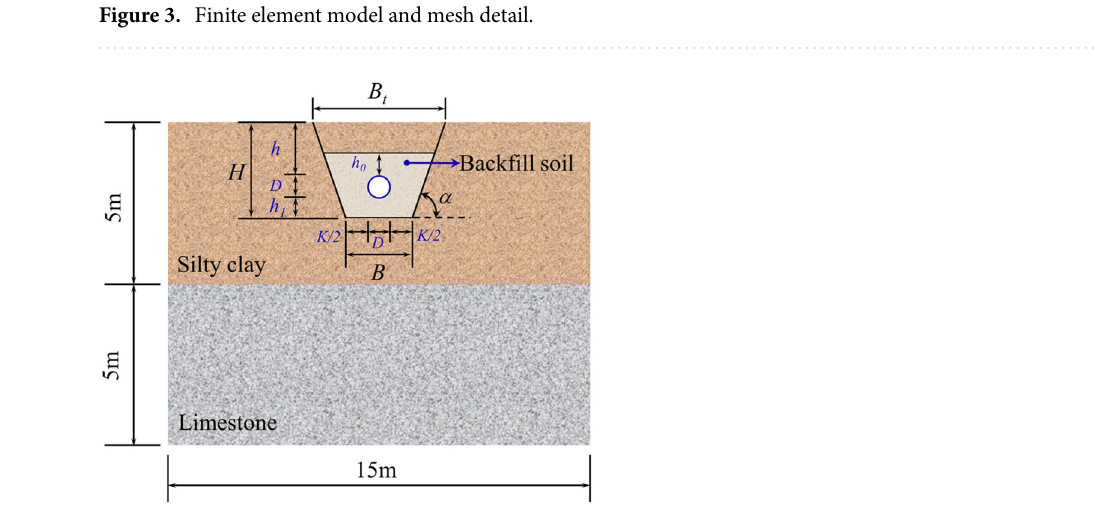
Figure 4. Cross-section schematic diagram of the FE